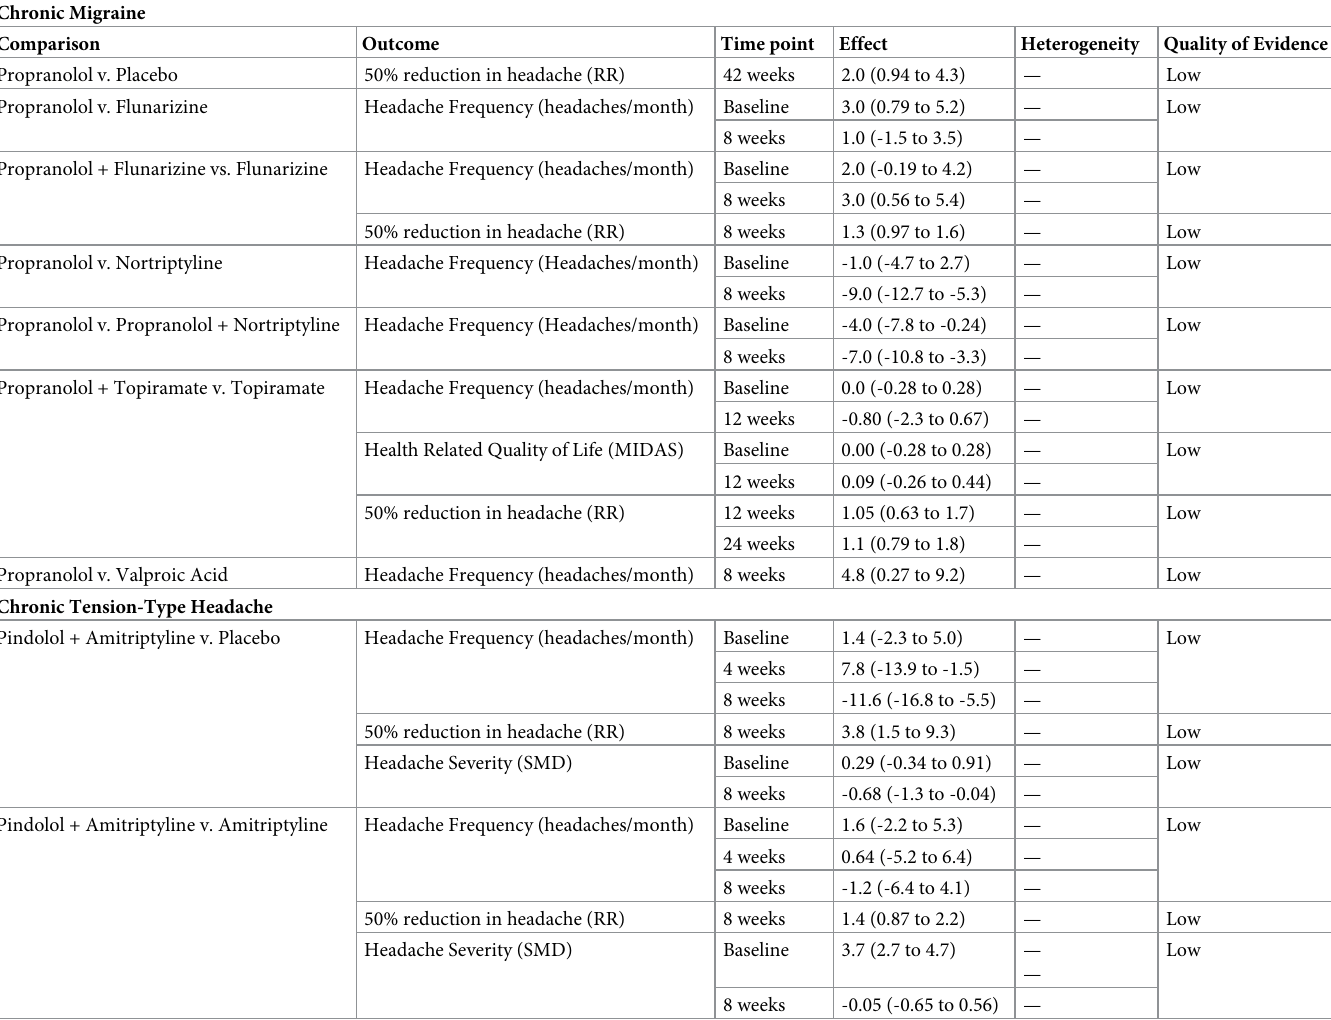
Table 6. Non-episodic